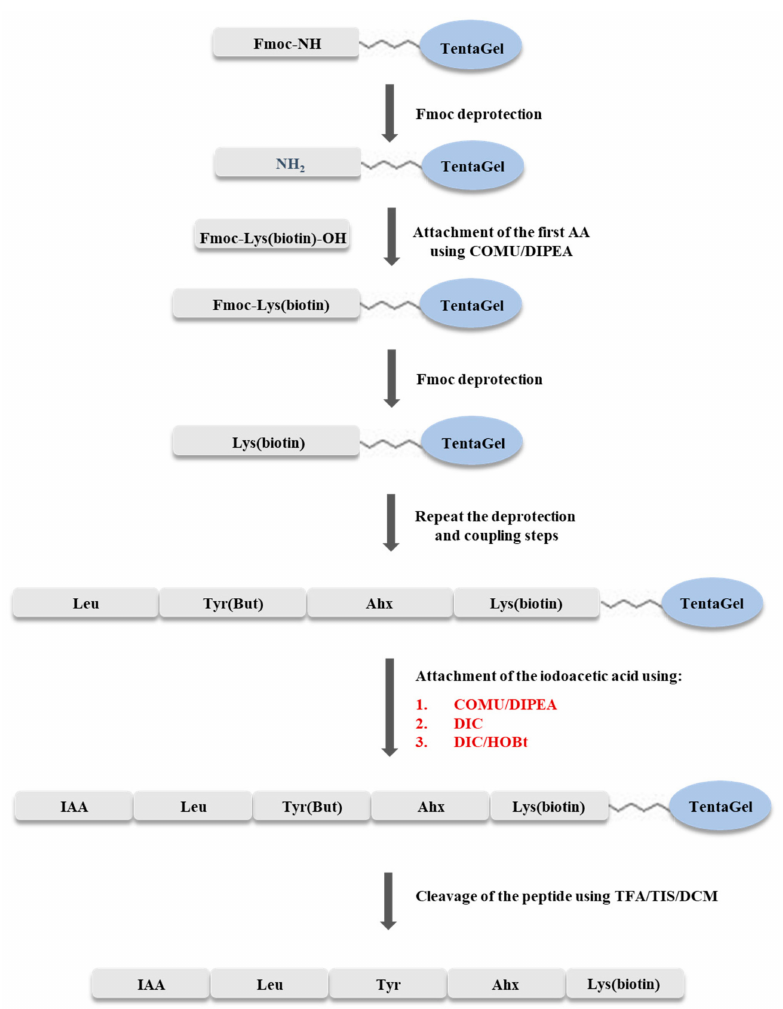
Figure 9. A scheme of the synthesis of IAA-Leu-Tyr-Ahx-Lys(biotin)-NH 2